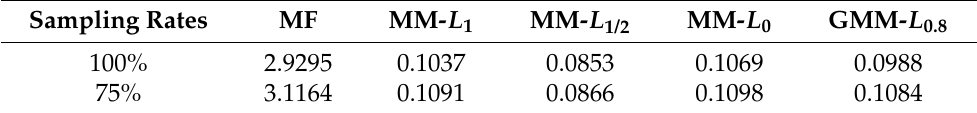
Table 4. The ENT of the